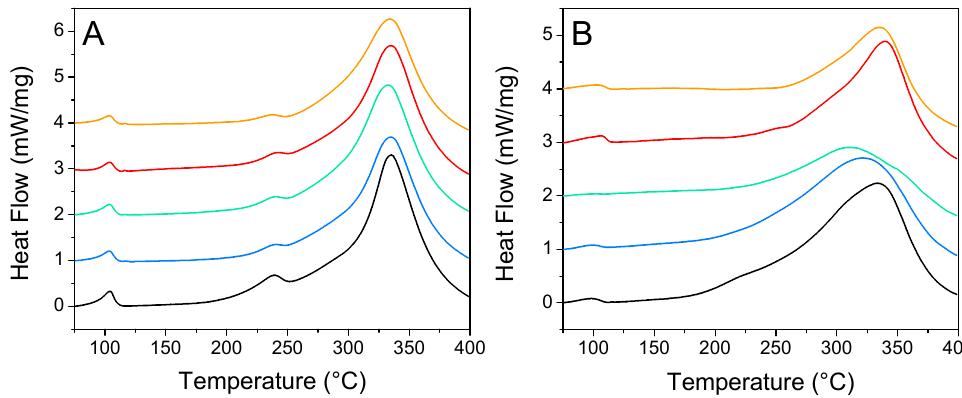
Figure 6. Differential scanning calorimetry from GN ( A ) and G2N ( B ) filled with LiBH 4 at 50% (vol) without (black) and with Fe (orange), Co (red), Ni (green), and Cu (blue) nanoparticles. Table 4. Calorimetric behavior of LiBH 4 -impregnated GN and G2N matrixes with and without metallic decoration.